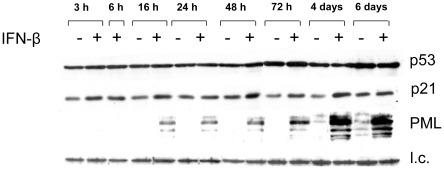
IFN-β affects the expression of proteins involved in senescence in K38 cells.Western blot analysis of PML, p53 and p21 expression in K38 treated with IFN-β for different time points. Whole cell extracts were resolved on SDS-PAGE and transferred onto PVDF membrane. Immunoblotting was performed as reported in M&M.